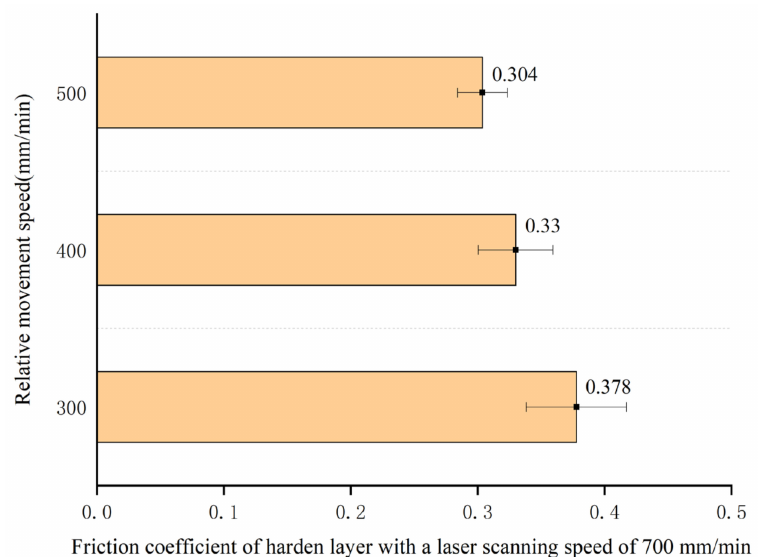
Figure 19. Friction coefficient of hardened layer with a laser scanning speed of 700 mm/min at different movement speed.